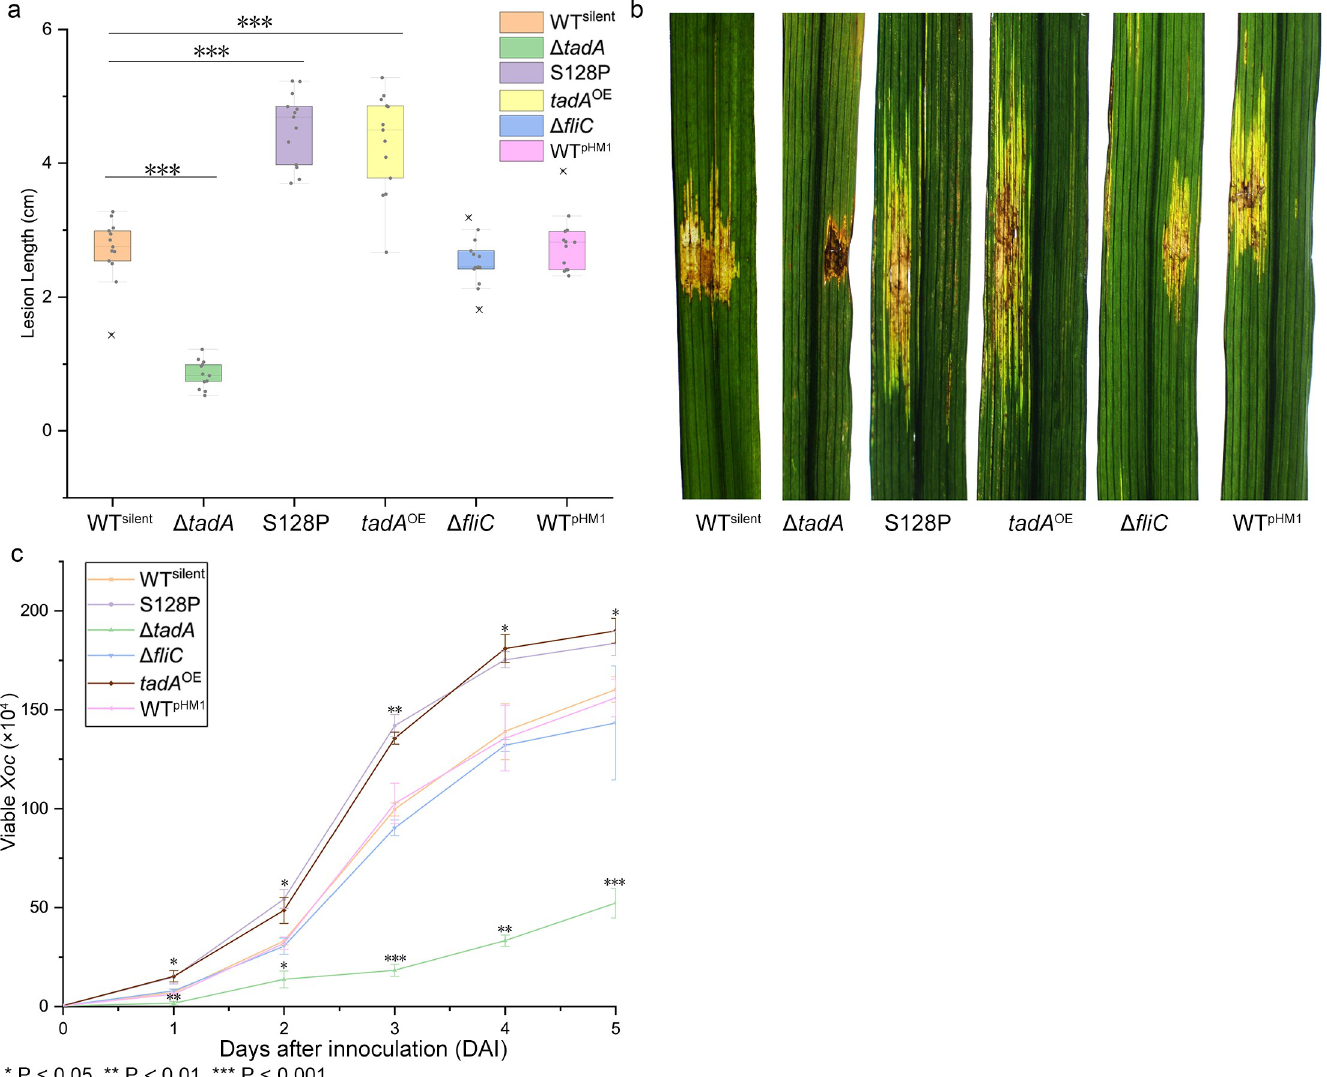
Fig 5. Virulence and in planta growth in rice cv. Zhenshan. Virulence was assessed by inoculating six-week-old susceptible Zhenshan 97 rice plants with Xoc strains. (a) Leaves ( n = 12) were inoculated with needleless syringes and evaluated for lesion length 14 days after inoculation. Values represent mean lesion length ± SD. The asterisks ( ��� ) indicate significant differences between the data obtained for Δ tadA , S128P and tadA OE as compared to the WT silent strain ( P < 0.001; ANOVA with Dunnett’s multiple test post-hoc correction compared with WT silent ). (b) Symptoms on rice leaves inoculated with the WT silent , S128P mutant, Δ tadA , tadA OE and WT pHM1 . (c) Population dynamics of WT silent , S128P, Δ tadA , tadA OE and WT pHM1 cells in planta (means ± SD). Three leaves, each infected with one strain of Xoc , were excised around the inoculation site and then crushed with sterile beads. Each suspension was subjected to a 10-fold serial dilution, and 5 μ l drops from the 10 − 1 – 10 − 6 dilutions were placed on NB agar with cephalexin. � , P < 0.05; �� , P < 0.01, ��� , P < 0.001.